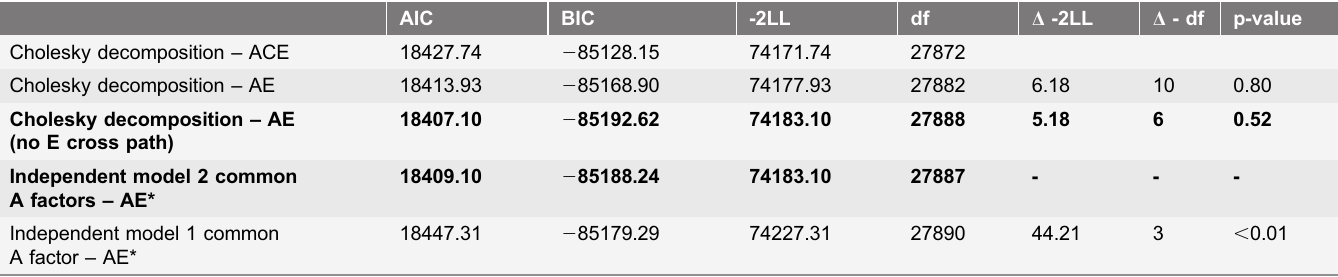
Table 3. Multivariate model fitting results for the three music aptitude measures (Pitch, Rhythm, and Melody) and WMT (last) corrected for age and sex with the best fitting models highlighted in